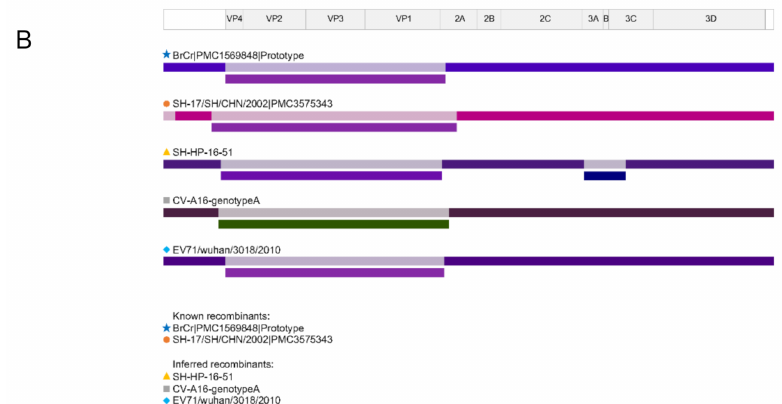
Figure 2. Recombination analysis of EV-A isolates. Gene sequences for the EV-A isolates selected in Figure 1 along with published recombinant strains BrCr (U22521) [136] and SH-17 / SH / CHN / 2002 (JX678885) [137] were analyzed. ( A ) Phylogenetic trees of di ff erent genomic regions. Individual gene sequences were retrieved from the ViPR website (https: // www.viprbrc.org / ). Trees were generated using RaXML with 100 bootstrap replicates, and subsequently visualized in Archaeopteryx.js on ViPR. CV-A16 strains are labeled in magenta; EV-A71 strains are labeled in green. Recombinant controls (BrCr, SH-17 / SH / CHN / 2002) are highlighted by navy and orange shapes, respectively. Three novel recombinants (SH-HP-16-51, CV-A16-genotypeA, EV71 / wuhan / 3018 / 2010) were inferred based on changes in their phylogenetic neighborhoods between individual genes and are highlighted by yellow, gray, and light blue shapes. ( B ) Recombination analysis of the same dataset using RDP4 [138] detected recombination events in recombinant controls (BrCr, SH-17 / SH / CHN / 2002) and the three inferred recombinants (SH-HP-16-51, CV-A16-genotypeA, EV71 / wuhan / 3018 / 2010) in regions consistent with the phylogenetic